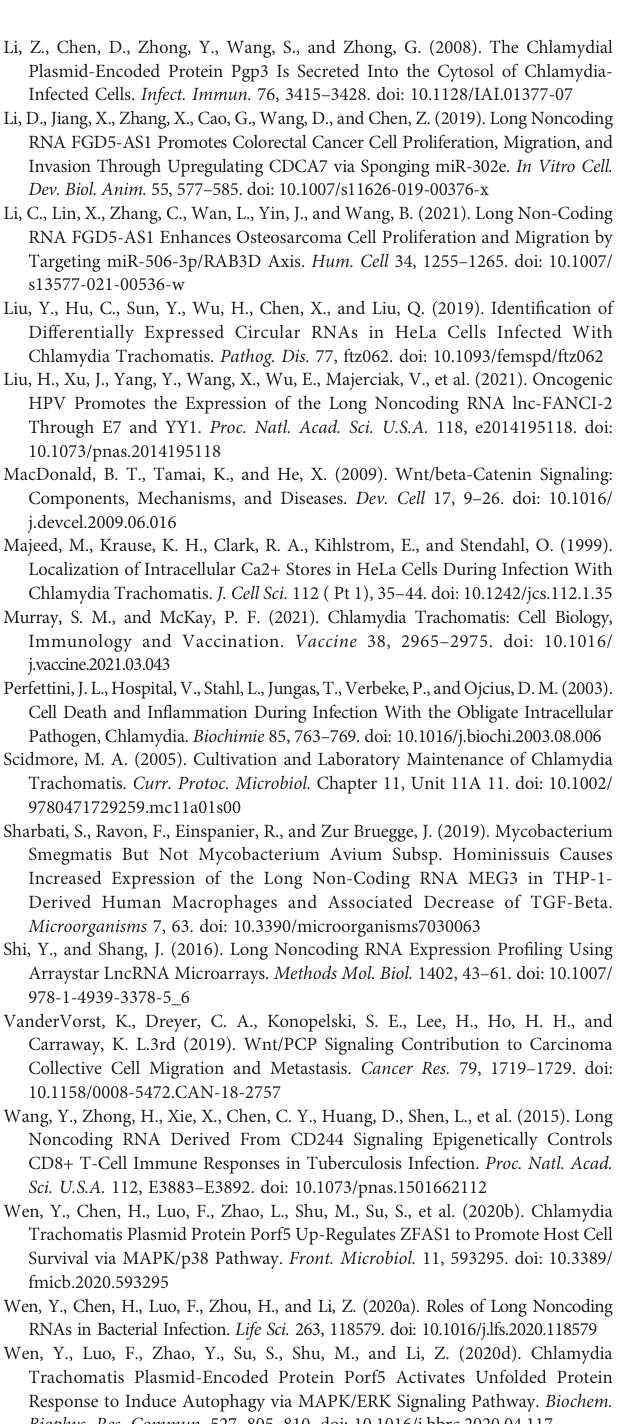
Supplementary Figure 6 | Protein-protein interaction (PPI) network of differentially expressed mRNAs. (A) Circos diagram shows the differentially expressed mRNAs at three time points. Red indicates alldifferential genes at 12 hpi, blueindicatesalldifferential genesat24 hpi,andgreenindicatesalldifferentialgenes at 40 hpi. Thelight orange in the inner circle indicates the unique differential genesat that time point, the dark orange indicates the overlap of genes at different time points, the purple line indicates the overlap between genes, and the blue line